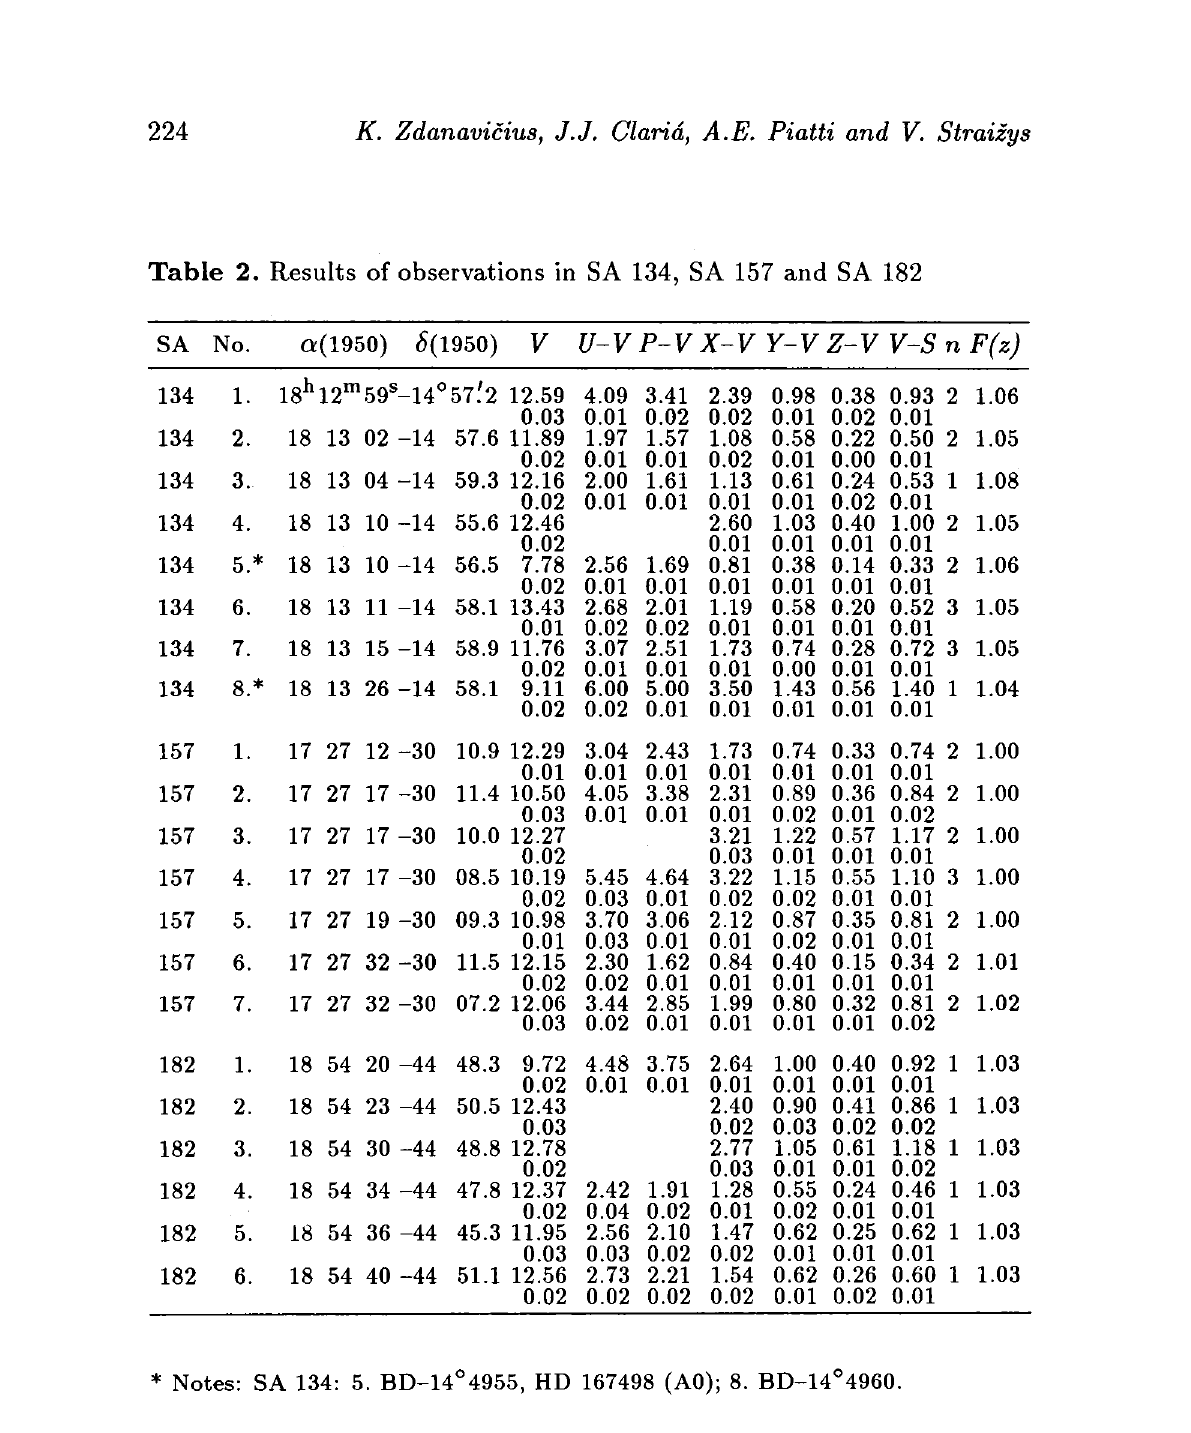
Table 2. Results of observations in SA 134, SA 157 and SA 182 SA